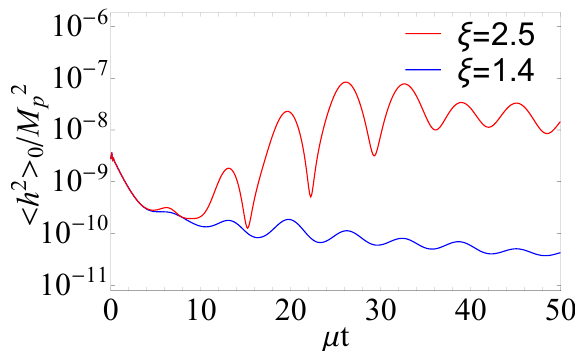
Figure 3. Time evolution of the Higgs field variance h h 2 i 0 for λ = 0 . The non-minimal Higgs-gravity couplings are taken to be ξ = 1 . 4 (blue) and ξ = 2 . 5 (red). We take µt end = 20 and 25 to derive the upper bound on ξ .